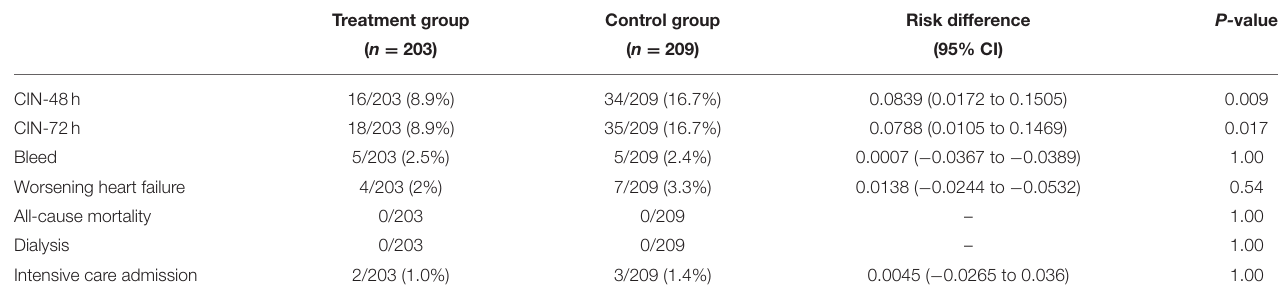
TABLE 3 | Incidence of contrast-induced nephropathy and major adverse events in